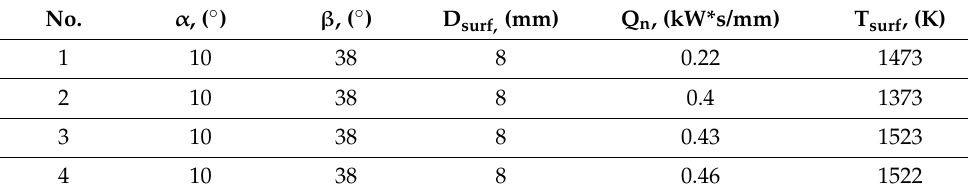
Table 2. Parameters of the mode of experiments on laser heat treatment.